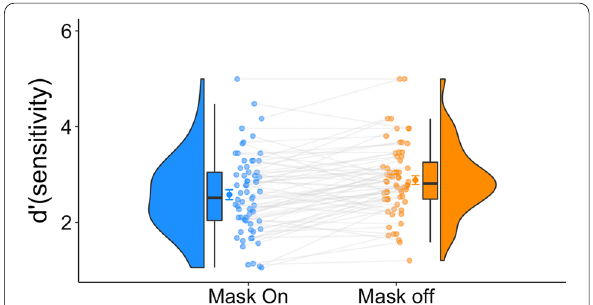
Fig. 2 Experiment 1 results. Better accuracy results were observed for the mask-off condition. For each condition, we present the distribution, the individual data points, and the quartiles of the dataset. The whiskers depict the rest of the distribution excluding outliers. The darker dots denote the means, and the error bars denote one standard